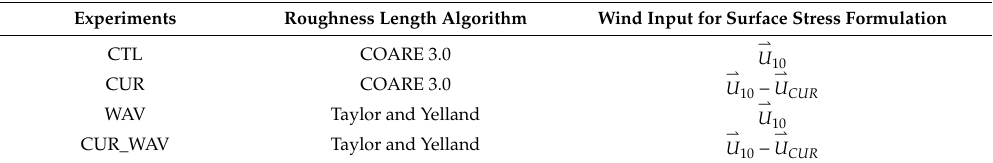
Table 1. Description of the experiments performed in this study. The (cid:42) U CUR is the ocean surface current. CTL, control experiment; CUR, ocean current experiment; WAV, and wave experiment; CUR_WAV, wave–currents–wind–stress three-way coupling experiment; COARE, Coupled Ocean-Atmosphere Response Experiment.